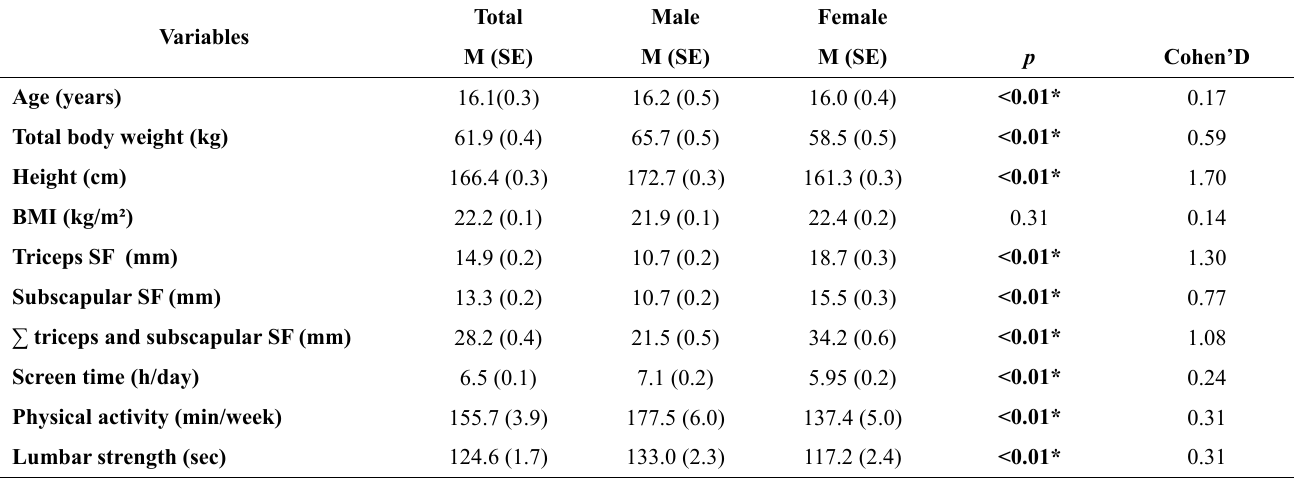
Table 1. Descriptive statistics of the sample according to sex. Variables